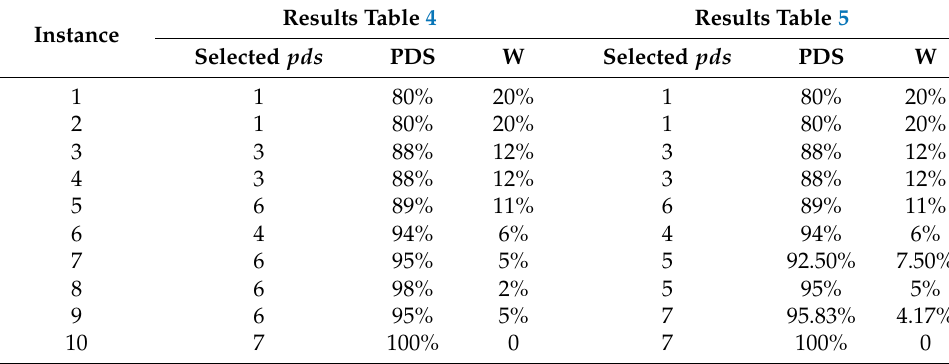
Table 6. Results of the selected pds and served